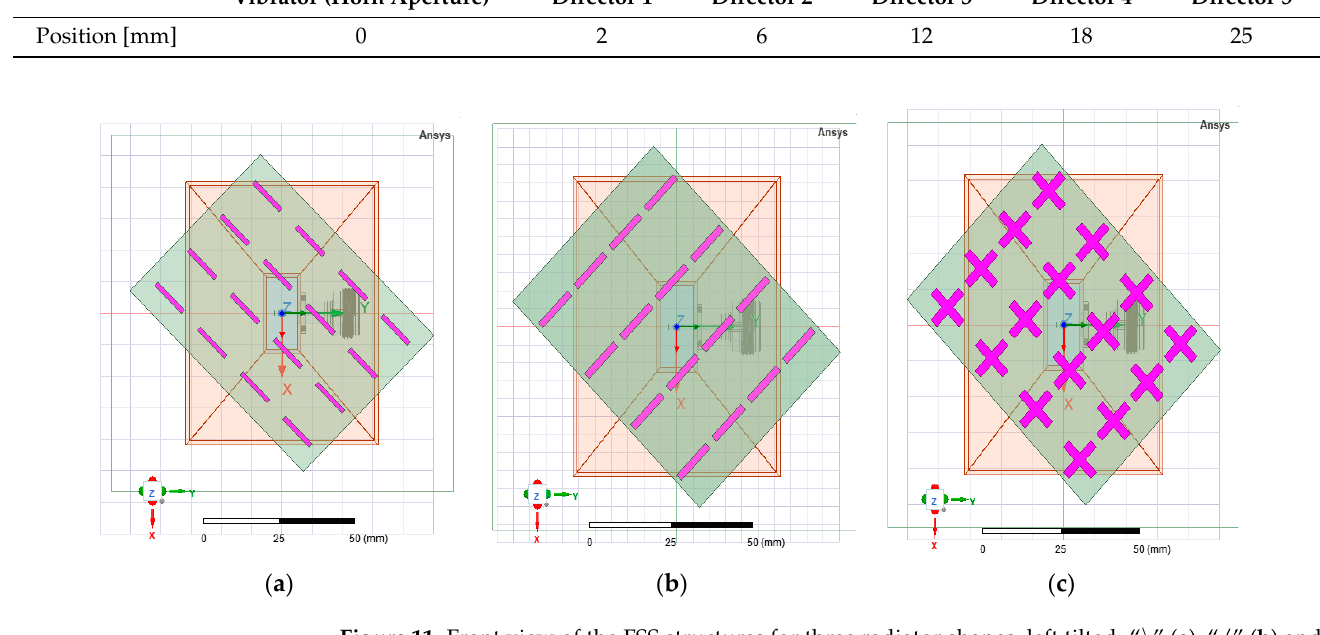
Figure 11. Front view of the FSS structures for three radiator shapes, left tilted: “\” ( a ), “/” ( b ) and “+” ( c ).